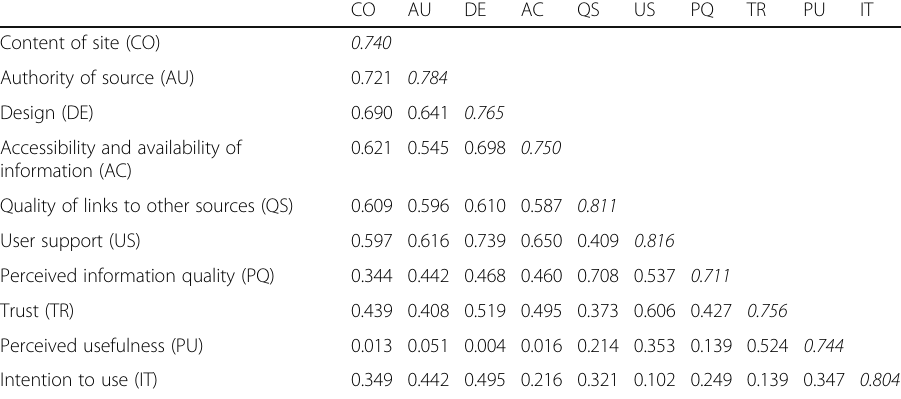
Italicized values (diagonal elements) are the square root of the average variance extracted (AVE). They show the variance shared between a construct and its measures. Off-diagonal elements are correlations between latent constructs. All correlations are significant at p <0.01